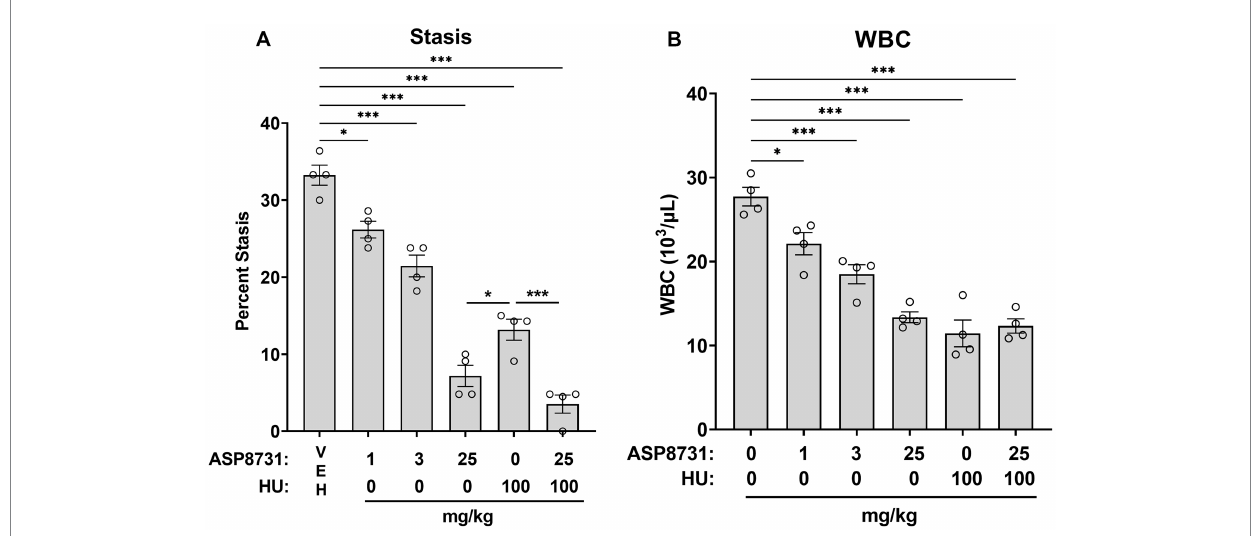
FIGURE 2 Bach1 inhibitor ASP8731 decreases microvascular stasis and WBC counts in Townes HbSS mice. Townes HbSS mice were gavaged once daily, 6 days per week for 4 weeks with vehicle (VEH), ASP8731, and/or HU at the indicated doses (n = 4 mice/group, 2 male and 2 female). On the last day of treatment, mice were implanted with dorsal skinfold chambers and infused with hemin (3.2 μ mol/kg body weight). Flowing venules (20–24 venules/ mouse) in the chamber window were selected and mapped using intravital microscopy prior to hemin infusion. (A) Microvascular stasis was measured in the same venules 1 h after hemin infusion. (B) WBC counts were measured in blood 4 h after hemin infusion. Individual values are presented as circles with bars representing the means ± SEM; * p < 0.05 and *** p < 0.001, one-way ANOVA with Tukey’s multiple comparison